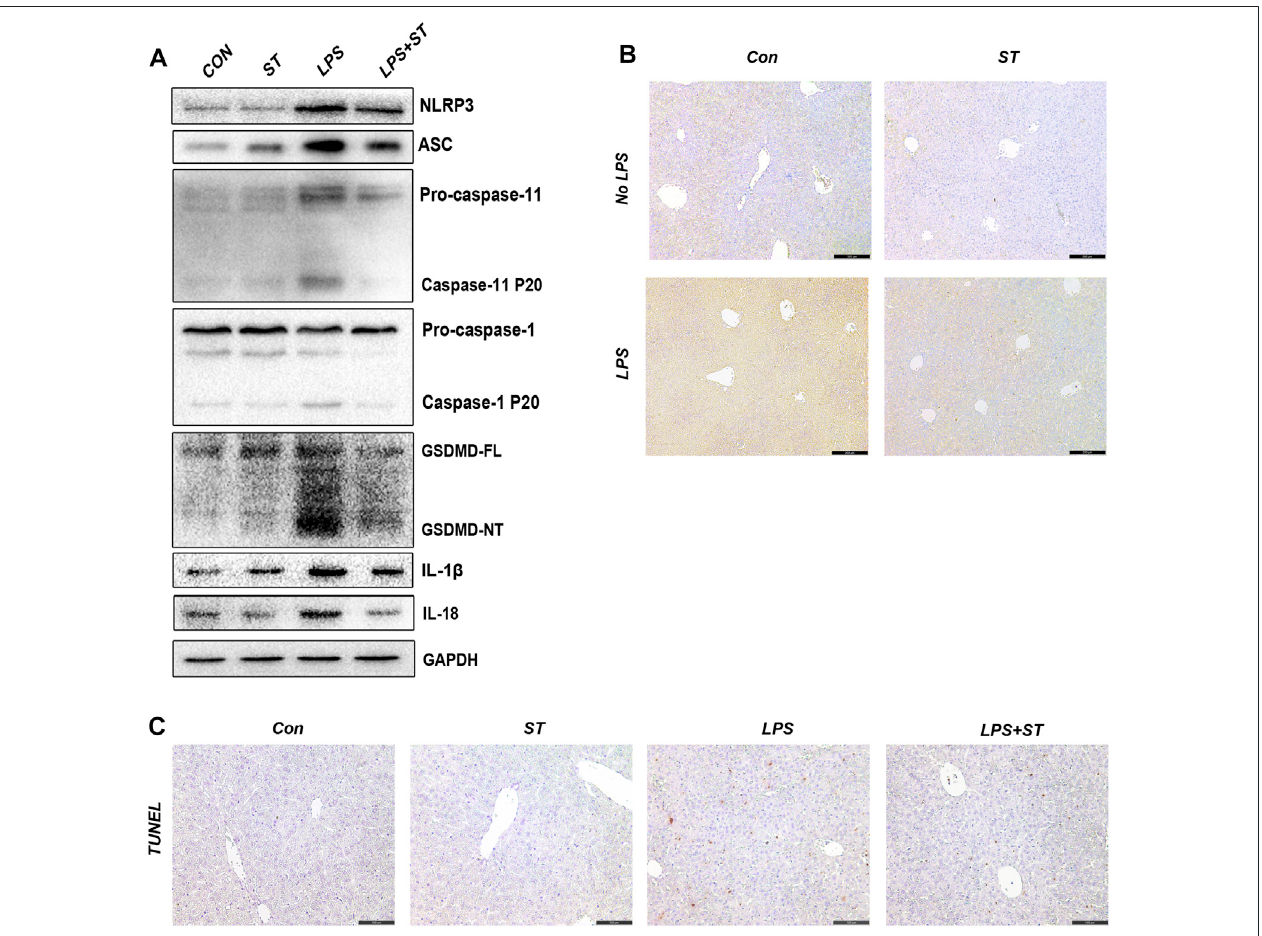
FIGURE 4 | Samotolisib suppresses the activation of caspase-11/pyroptosis in LPS-induced liver injury. (A) The protein levels of pyroptosis markers assessed usingwesternblotting. (B) Representativeimmunohistochemistry(IHC)imagesofcaspase-11inliversections(scalebars (cid:1) 200 μ m). (C) TUNELstainingofliversections (scale bars (cid:1) 100 μ m). Data are presented as the mean ± SD; * p < 0.05, ** p < 0.01, *** p < 0.005.